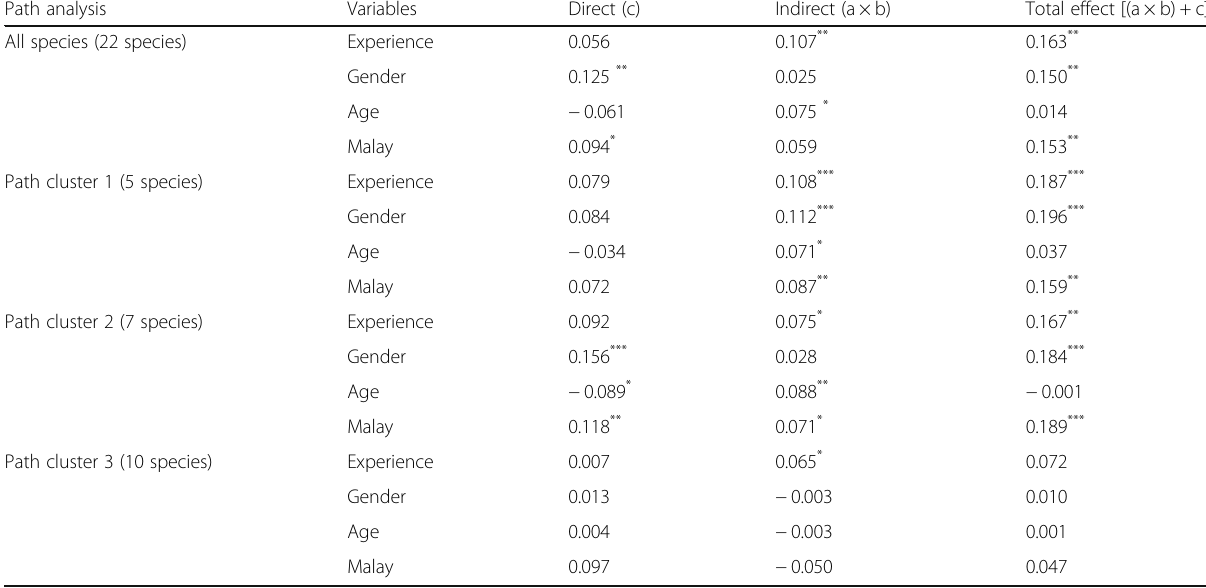
Table 1 The standardized path coefficients for direct, indirect, and total effects on willingness to coexist (Coexistence) with wild animals (see Figs. 2 and 4 for further details). Male and Malay are the reference categories for gender and ethnicity, respectively Path analysis